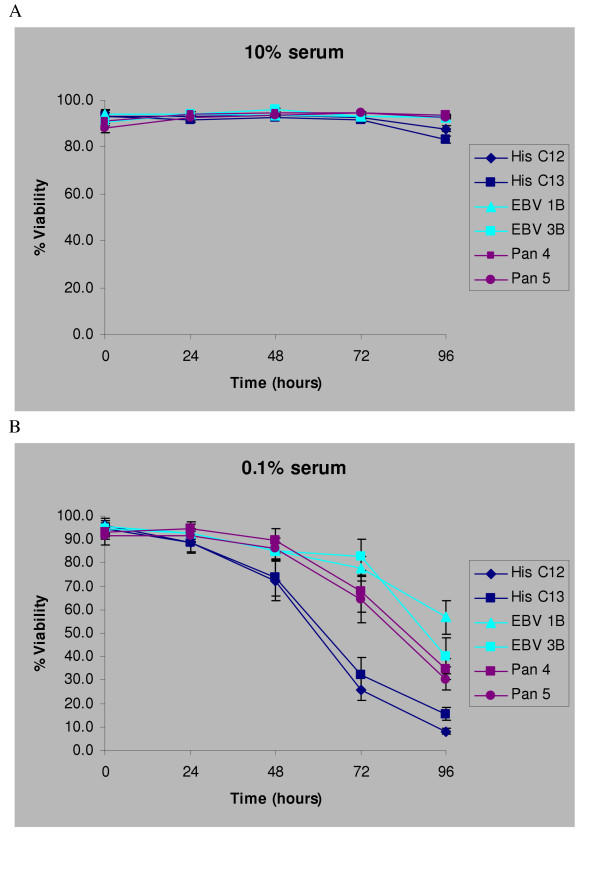
Determination of apoptosis levels in reduced serum conditions. The percentage viability of EBV and H. pan BHRF1 Ramos-BL transfectants compared to vector controls in medium containing A) 10% serum or B) 0.1% serum over a 4 day period. The % viability was determined daily by acridine orange fluorescence. The data plotted are the means three experiments carried out in triplicate ± standard error. Statistical analysis was performed using ANOVA and Tukey's pairwise comparison on data normalised by arcsine transformation.